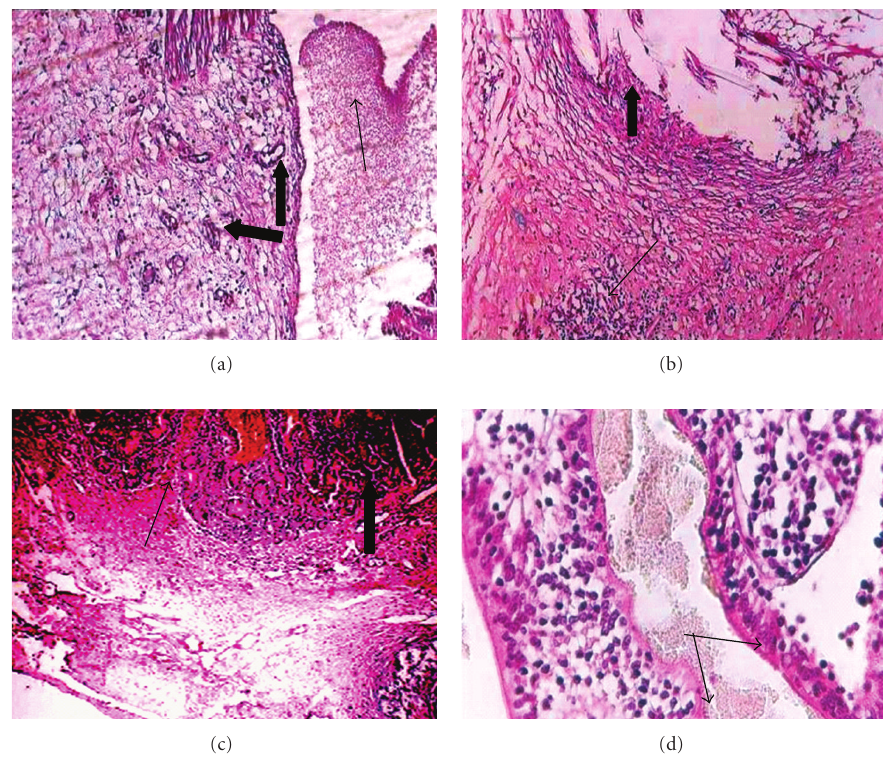
Figure 3: Histopathology photographs of experimental intestinal anastomosis in goat, SSIS group. (a) Organized thrombus in the anastomosis site on 4th POD (thin arrow) and new blood vessels (thick arrow), H&E stain, × 10. (b) On 14th POD: granulation tissue infiltrated with lymphocytes in the serosa and submucosa, new blood vessels (thin arrows), and epithelial cells (thick arrow), H&E stain, × 10. On 21st POD, (c) anastomotic line completely filled with scar tissue (thin arrow), scant fibroblasts, lymphocytes, epithelial cells, intestinal glands, and crypts of Lieberk¨uhn (thick arrow), H&E × 20. (d) Long villi and microvilli (arrow) lined the intestinal mucosa, H&E stain, × 40.